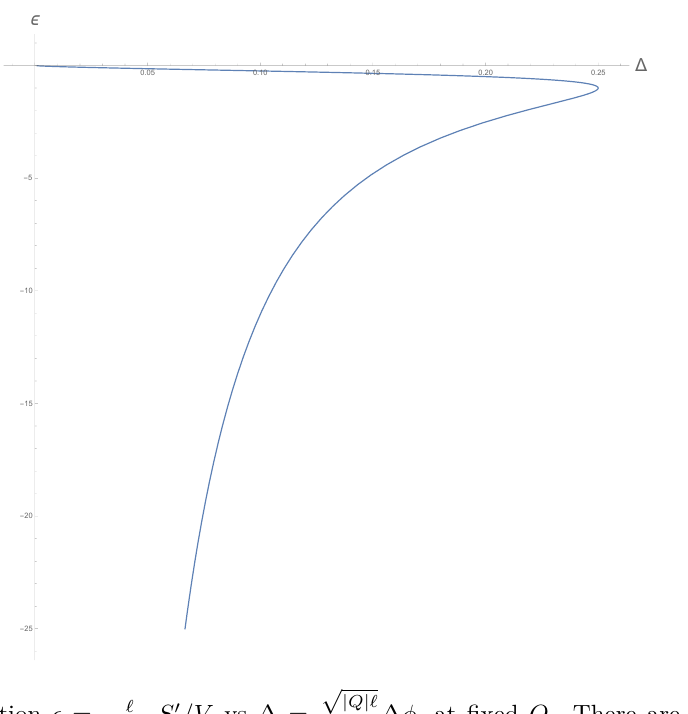
Figure 2 . The action (cid:15) = ‘ each boundary condition for ∆ φ < ∆ φ max . The supersymmetric solution is at the maximum value ∆ φ = ∆ φ max